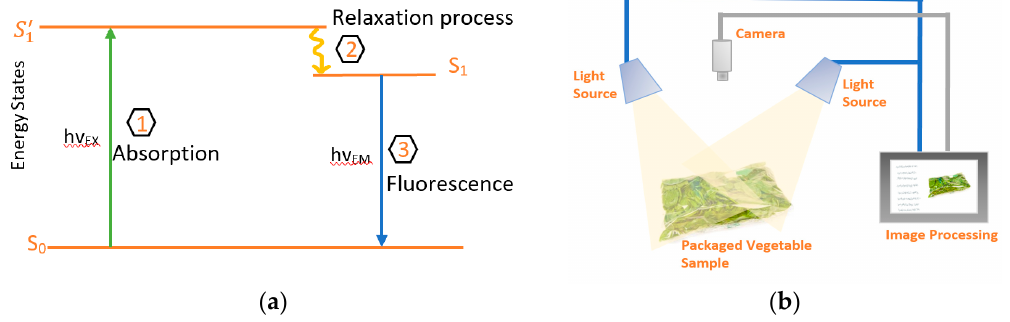
Figure 5. ( a ) Jablonski diagram illustrating the excitation and emission process. ( b ) Schematic of general Chl fluorometer system.